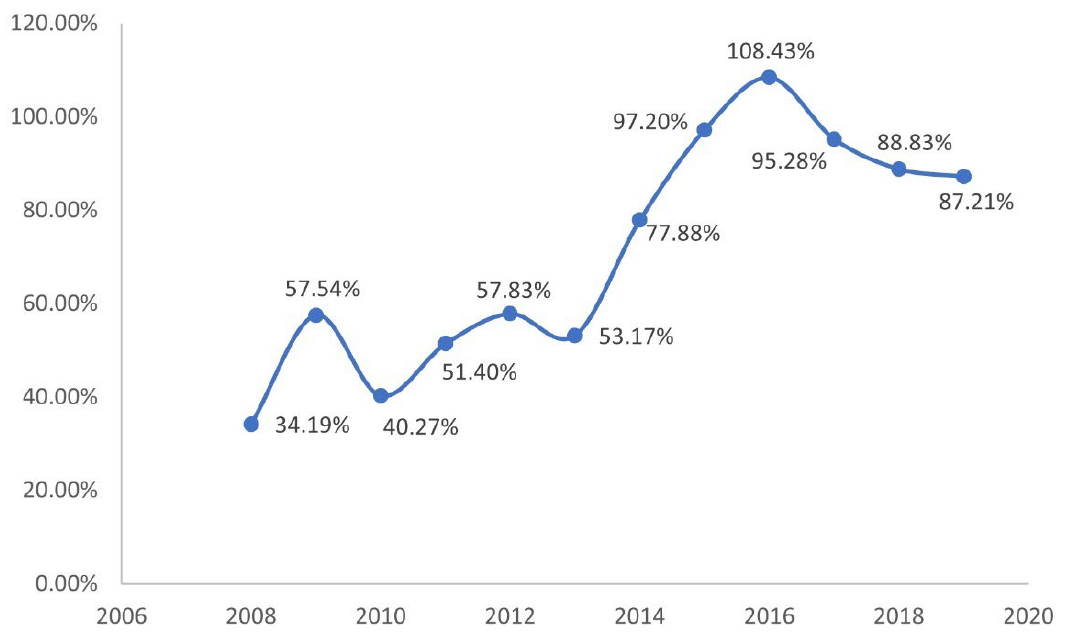
Figure 6. Indicators of water resource shortage in Tarim River basin during 2008–2019. Data source: According to the statistical yearbook of Xinjiang.